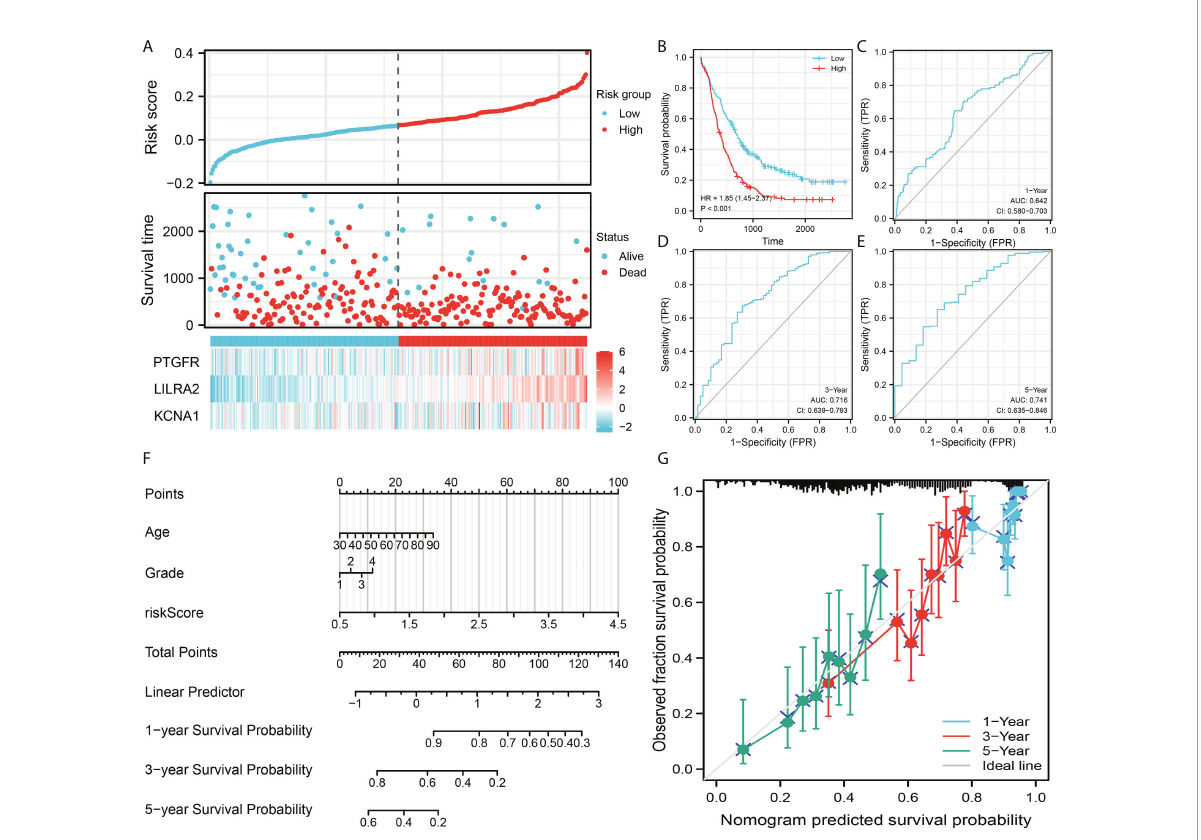
FIGURE 4 Model validation and nomogram. (A) Overview of the model in the validation group; (B) Kaplan-Meier survival curves of patients in high and low risk group in the validation group; (C – E) ROC curves of the 1-, 3- and 5-year survival; (F) A nomogram was established by combining the riskscore and clinical features; (G) Calibration curves indicated a good fi tting degree between the nomogram predicted survival and the actual